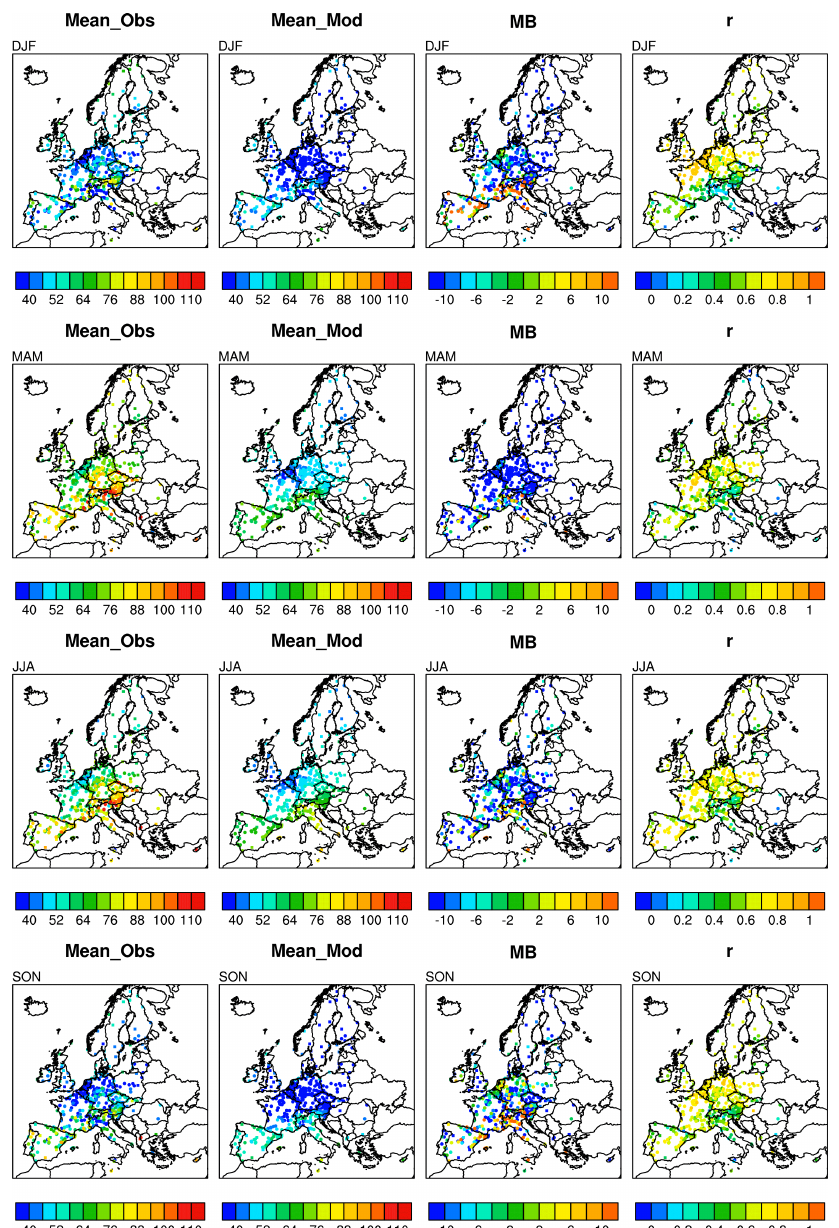
Figure 10. Seasonal average values of surface O 3 in µgm − 3 from hourly measurements at AirBase (circles) and EMEP (squares) stations, and modeled values from RADM2 for corresponding locations. The MB (in µgm − 3 ) and temporal correlation coefficient ( r ) for hourly values are also shown at the location of station